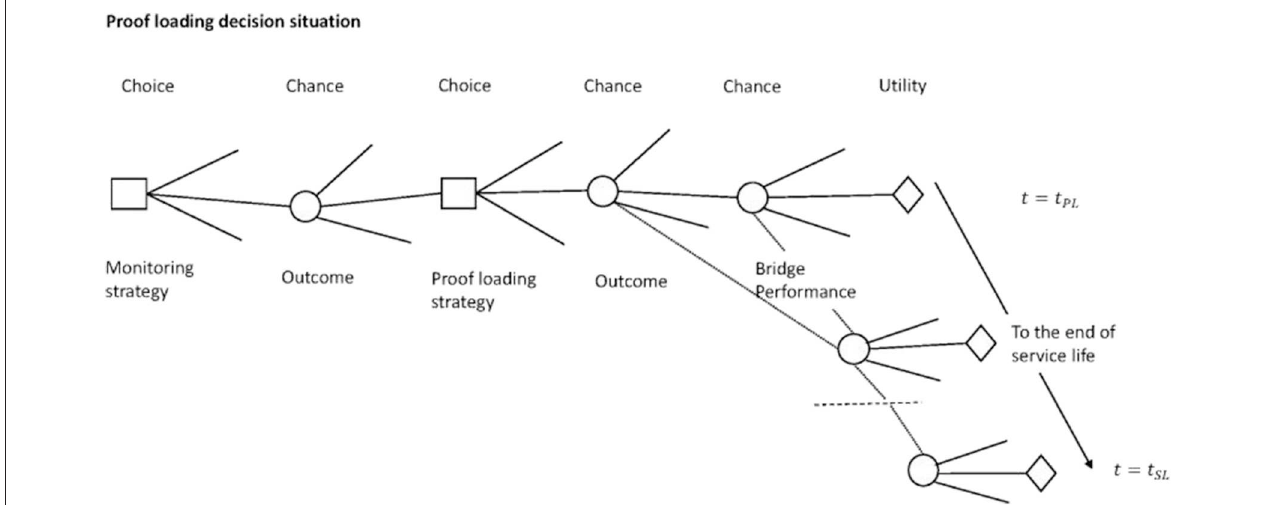
FIGURE 4 | Illustration of decision situation 1: proof loading of the bridge with a decision tree encompassing the choice of the proof loading and monitoring strategy.